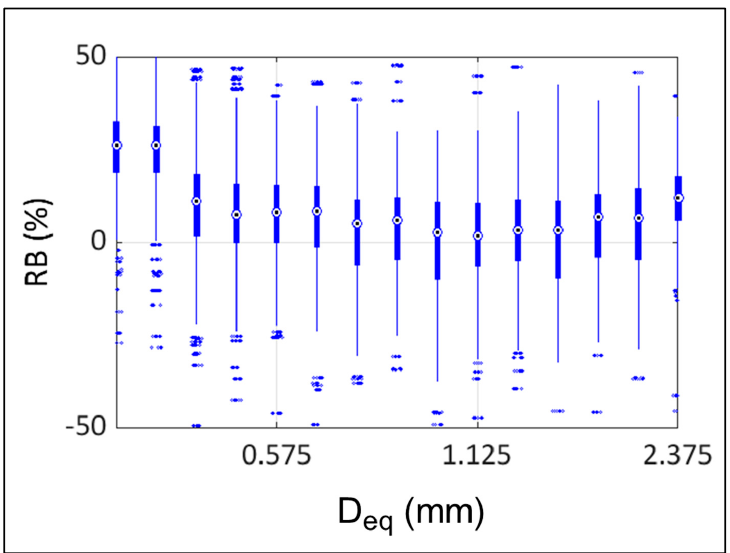
Figure 4. Relative bias in N(D) if we use the most probable h(x) from GXY and HSV to reconstruct Dorian rainband DSDs.